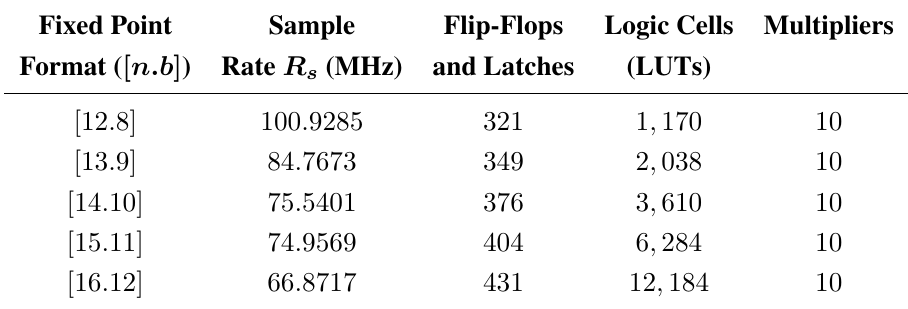
Table 4. Processing speed and area occupied for different fixed point formats, in the XOR gate scenario. LUT, lookup table.